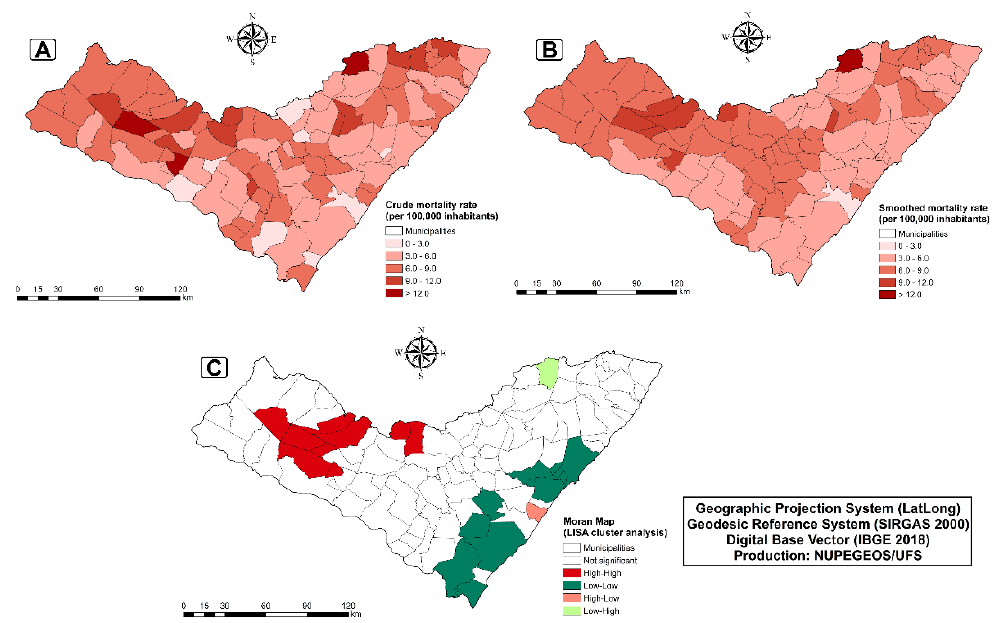
Figure 2. Spatial distribution of mortality rates due to diarrhea and infectious gastroenteritis in the state of Alagoas: Crude mortality rate ( A ); Smoothed mortality rate ( B ) and Moran map ( C ) (spatial autocorrelation). A). The primary cluster covered 67 municipalities considered to be at high risk from 2000 to 2008 (mortality rate = 10.11/100,000 inhabitants; RR = 3.67; Table 3). The secondary cluster included 20 municipalities between 2000 and 2007 (12.51/100,000; RR = 2.37). Importantly, all municipalities in those two clusters were from the interior of the state.